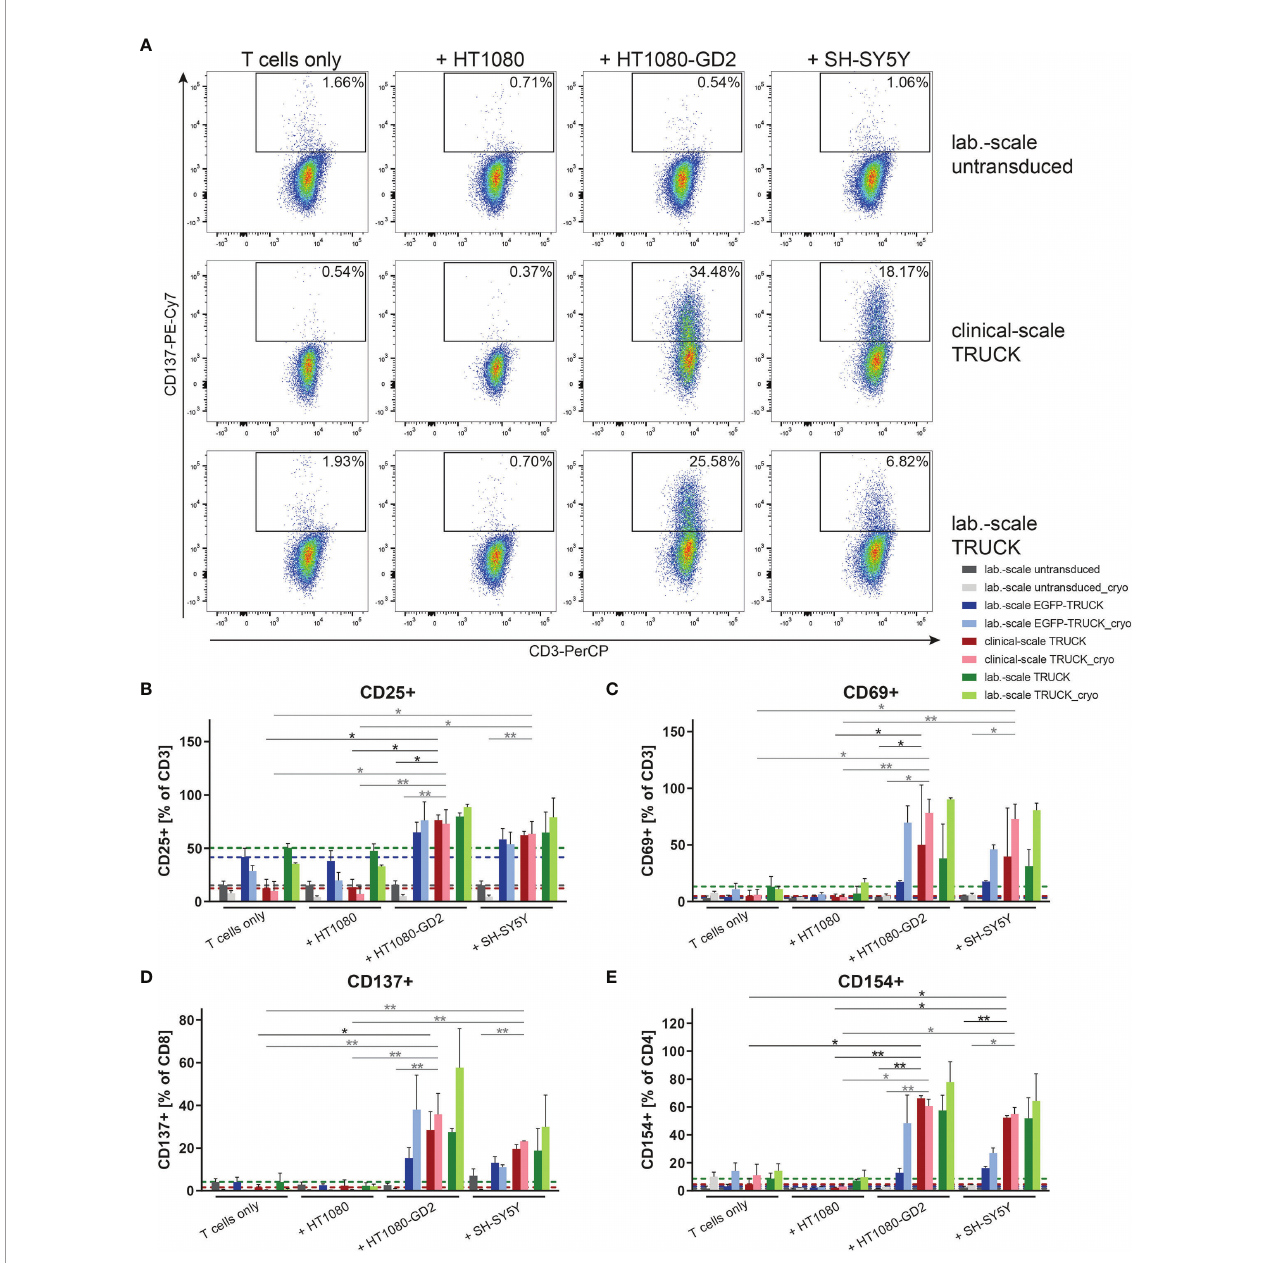
FIGURE 4 | Clinical-scale-manufactured IL-18 TRUCKs targeting GD 2 speci fi cally respond to GD + 2 target cells with an increase of activation marker expression. IL- 18 TRUCKs targeting GD 2 were generated using the CliniMACS Prodigy ® (clinical-scale TRUCK; n=2) or under laboratory conditions (lab.-scale TRUCK; n=3). Untransduced T cells (lab.-scale untransduced; n=3) as well as GD 2 TRUCKs with inducible EGFP expression (EGFP-TRUCK; n=3) served as control. The manufactured cells were tested for GD 2 -CAR-mediated activation either directly after the generation process (d12) or after cryopreservation and thawing (cryo) by co- cultivation with the indicated target cells for 48h in an effector-to-target (E:T) ratio of 4:1 or cultivation alone (T cells only). (A – E) Frequency of (A) CD137 + of CD8 + as representative plots , (B) CD25 + of CD3 + , (C) CD69 + of CD3 + , (D) CD137 + of CD8 + and (E) CD154 + of CD4 + T cells as determined by fl ow cytometry. (B – E) A dashed line indicates background levels of the respective expression by untransduced T cells (grey), EGFP-TRUCKs (blue), as well as clinical-scale (red) and laboratory-scale (green) TRUCKs cultured alone. Data is shown as mean ± SD. Statistical differences of clinical-scale TRUCKs co-cultured with different target cells after generation or cryopreservation as well as in comparison to laboratory-scale manufactured cells were assessed by Kruskal-Wallis and Dunn ’ s test, signi fi cant differences are shown (*p ≤ 0.05, **p ≤